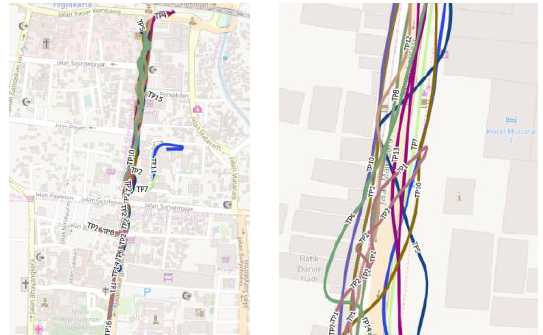
Figure 5. All tracks during the test (left); their enlarged view